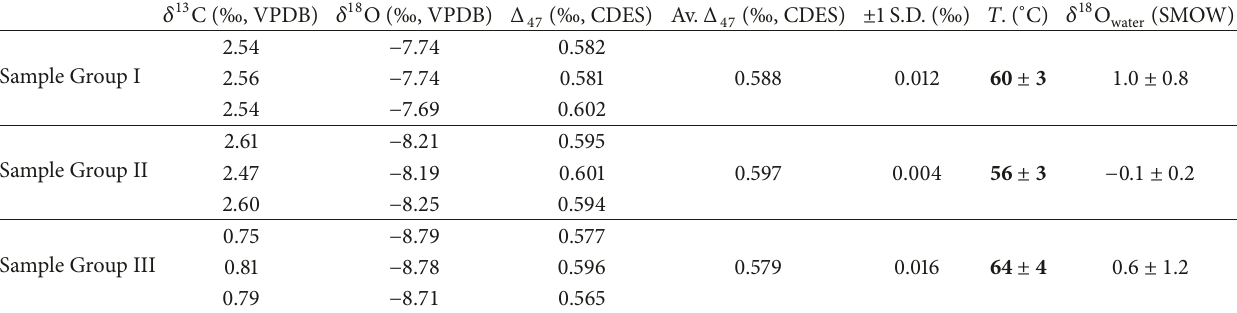
Table 2: Data from clumped isotopes analyses.